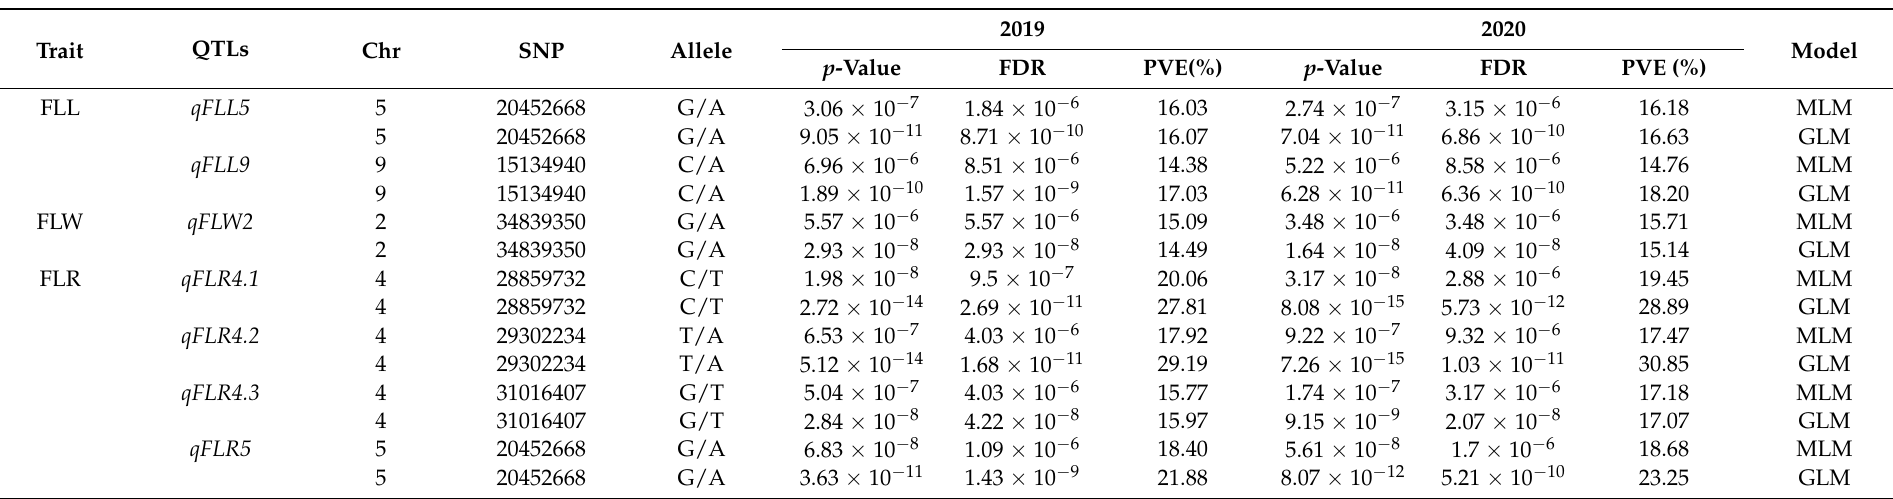
Table 2. SNP Positions for FLL, FLW, and FLR identified by GWAS, the proportion of phenotypic variance explained (PVE), and p -value in 2019 and 2020.